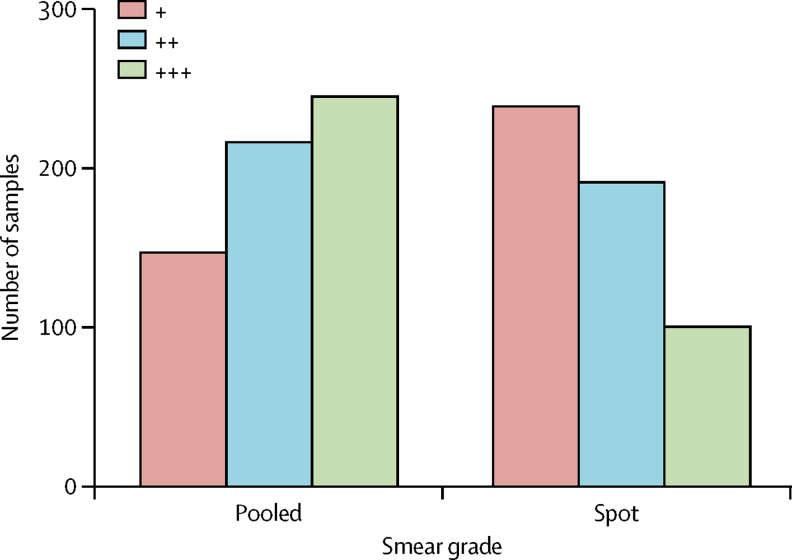
Comparison of the differences in mycobacterial load within smear microscopy positive samples between pooled and spot sputum collectionsThis analysis involved combining the results reported by Andrews and Radhakrishna (1959)29 and Majumdar and colleagues (1962),30 which showed 75% (608 of 807) of positive smear microscopy results in pooled sputum collections compared with 66% (530 of 807) in spot sputum collections. Smear grade is indicated by the number of + symbols. Because only aggregate data for these studies were published, matched analysis was not possible. Therefore, the p value (<0·0001) was calculated from a Wilcoxon-Mann-Whitney rank sum test.